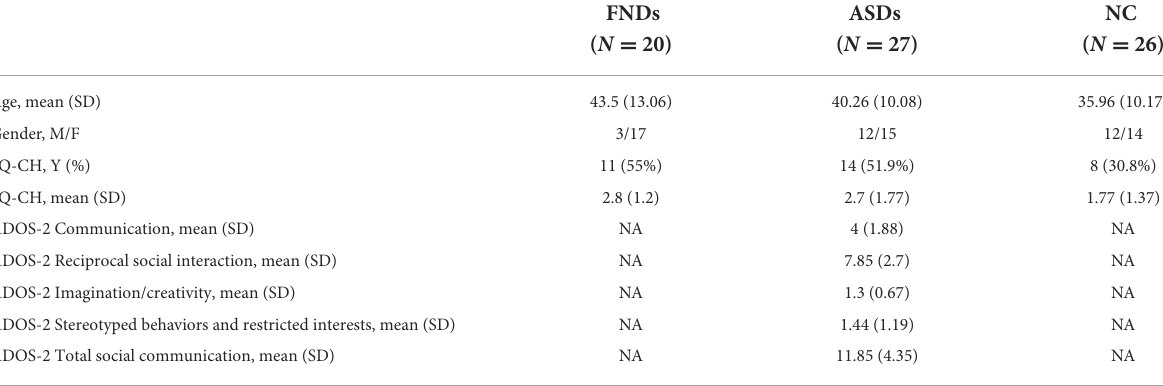
TABLE 2 Demographic and clinical information for FNDs, ASDs and NC groups.